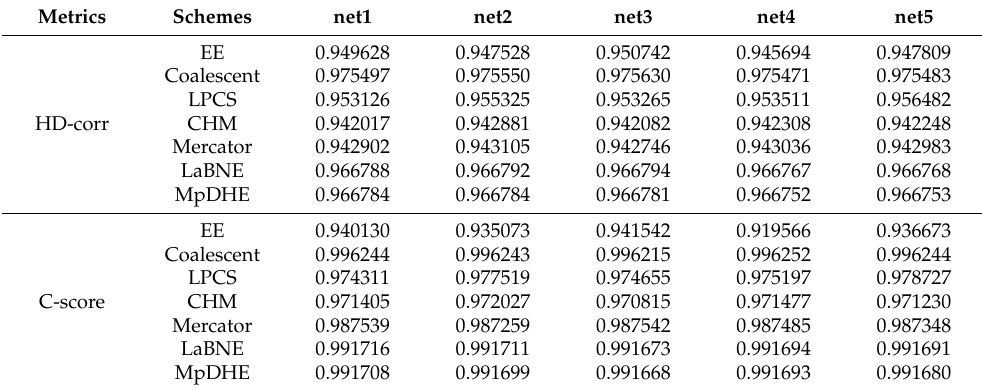
Table 3. The hyperbolic embedding performance with different time